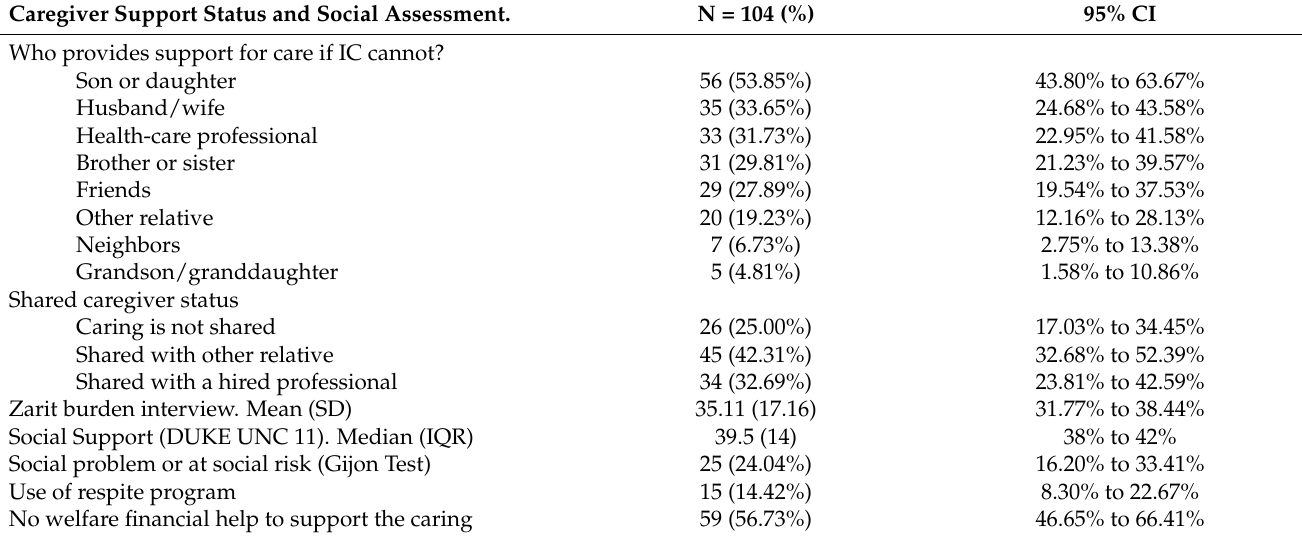
Table 3. Informal caregiver support status and social